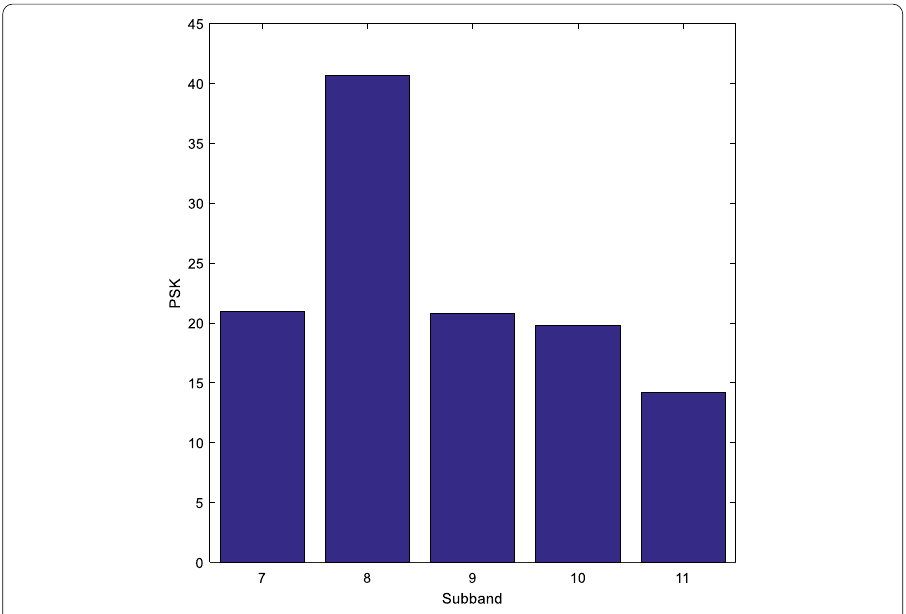
Fig. 5 Result of optimal characteristic sub-band selection. The figure shows the PSK value of each characteristic sub-band